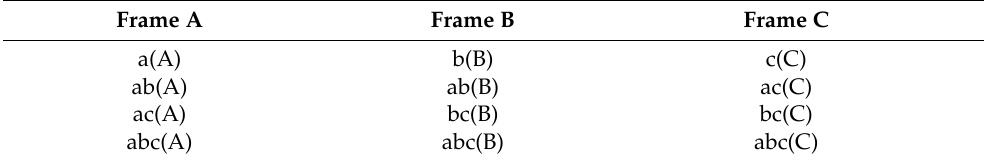
Table 1. Partition of multi-frame samples into frame-specific domains: example with Q = 3: { A,B,C } . Frame